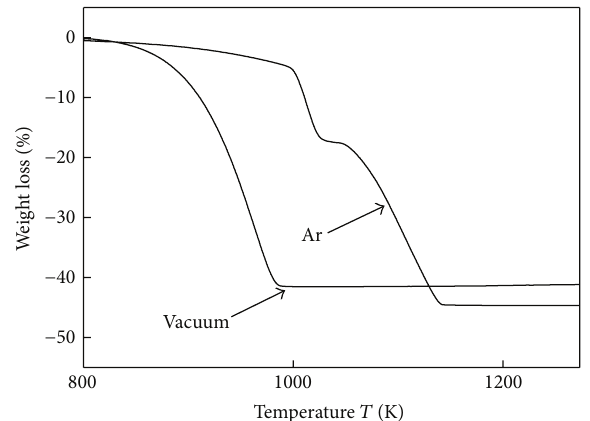
Figure 2: TG curves of dolomite decomposition in an Ar atmo- sphere and